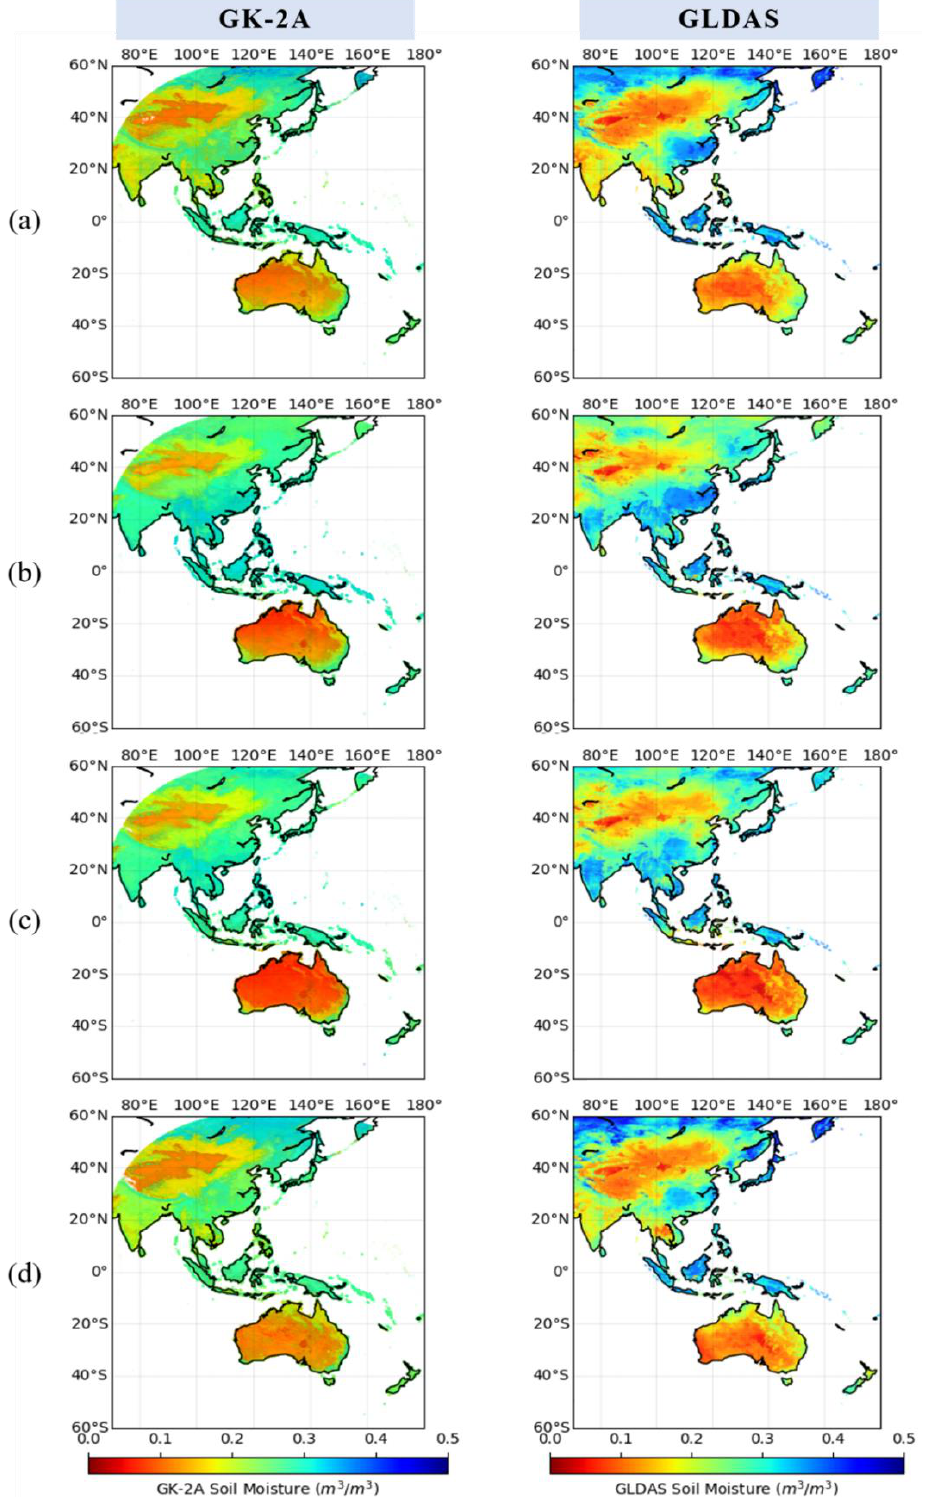
Figure 9. Spatial distribution of GK-2A and GLDAS SM during four seasons: ( a ) spring (March,